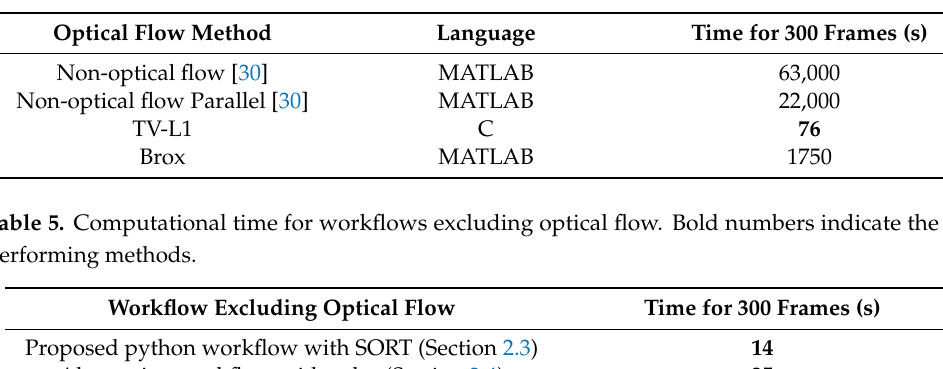
Table 4. Comparison of computational times for optical flow methods and an earlier method [30]. Bold numbers indicate the best performing methods.